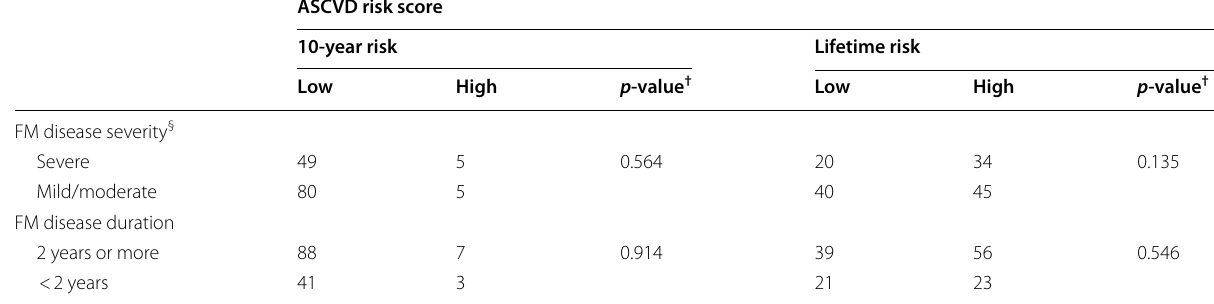
ASCVD, atherosclerotic cardiovascular disease; FM, fibromyalgia †